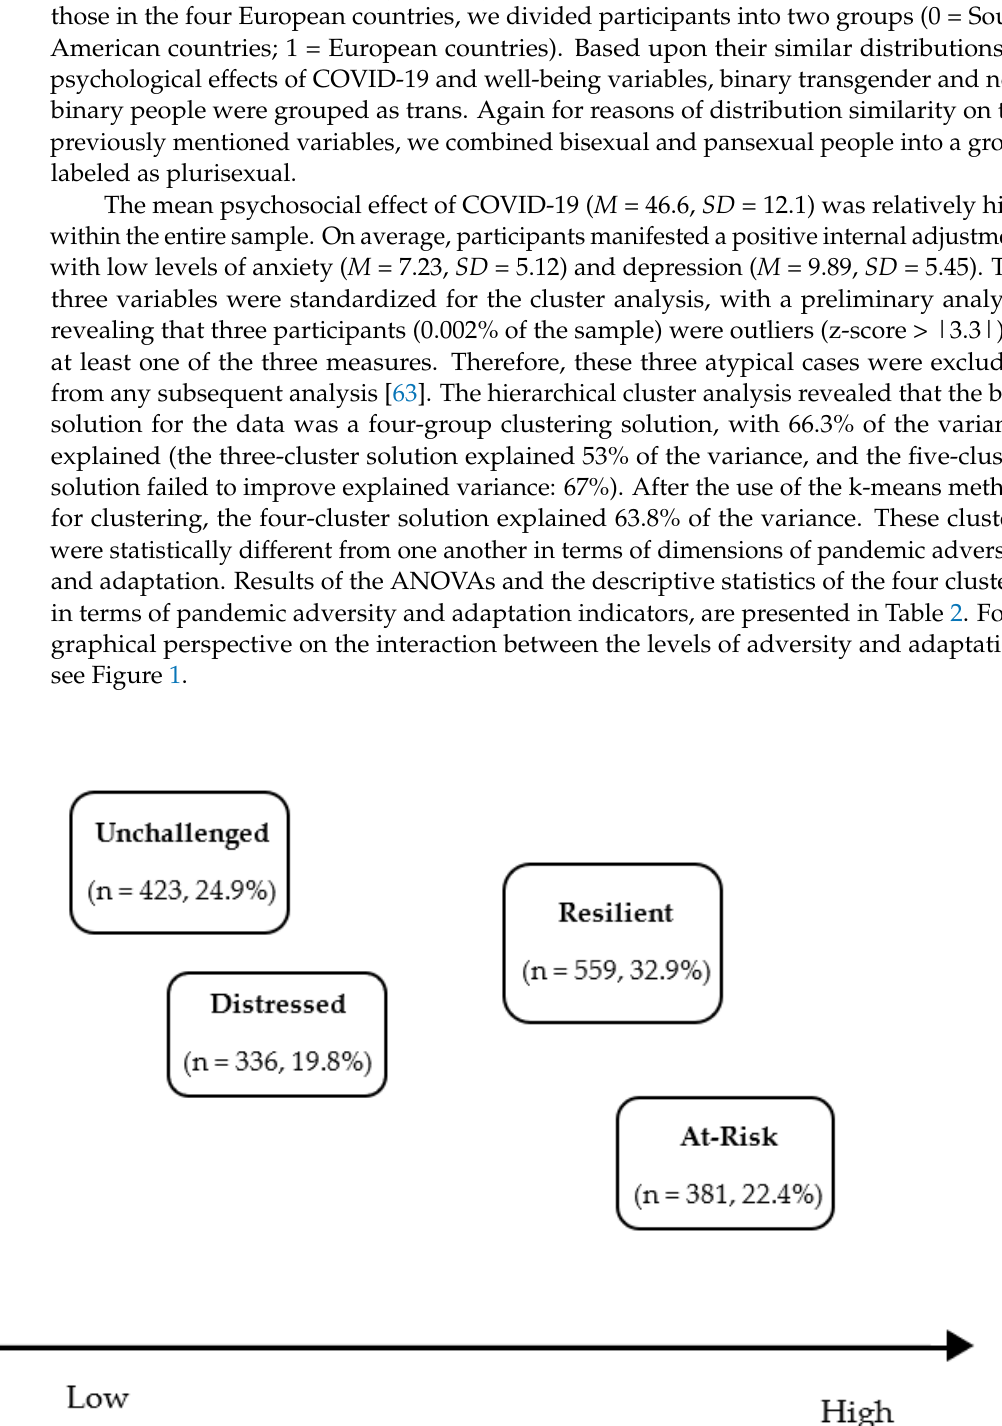
Figure 1. Schematic positioning of the four patterns of adjustment to the psychosocial effect of COVID ‐ 19. Table 2. Means and Standard Deviations of Psychosocial effect of COVID ‐ 19, Anxiety, and Depres ‐ sion for Each Cluster.